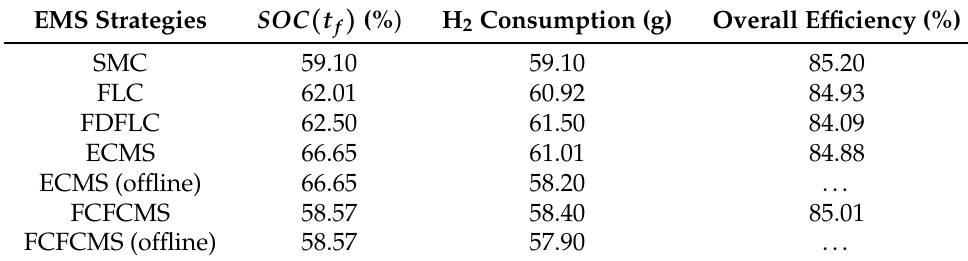
Table 4. Overall performance obtained for the different studied energy management strategies. SMC: State Machine Strategy, FLC: Fuzzy Logic Control, FDFLC: Frequency Decoupling and FLC, ECMS: Equivalent Consumption Minimization Strategy, FCFCMS: FC Fuel Consumption Minimization Strategy; the initial value is SOC ( t o ) = [65%].